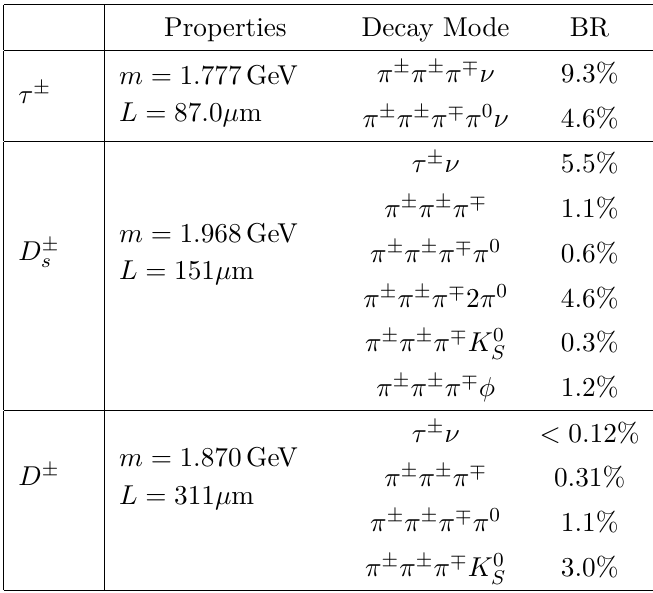
Table 4 . Invariant mass and mean decay length ( L ) of τ leptons and charged D mesons [30]. Some decay modes relevant to this study and their branching ratios are also